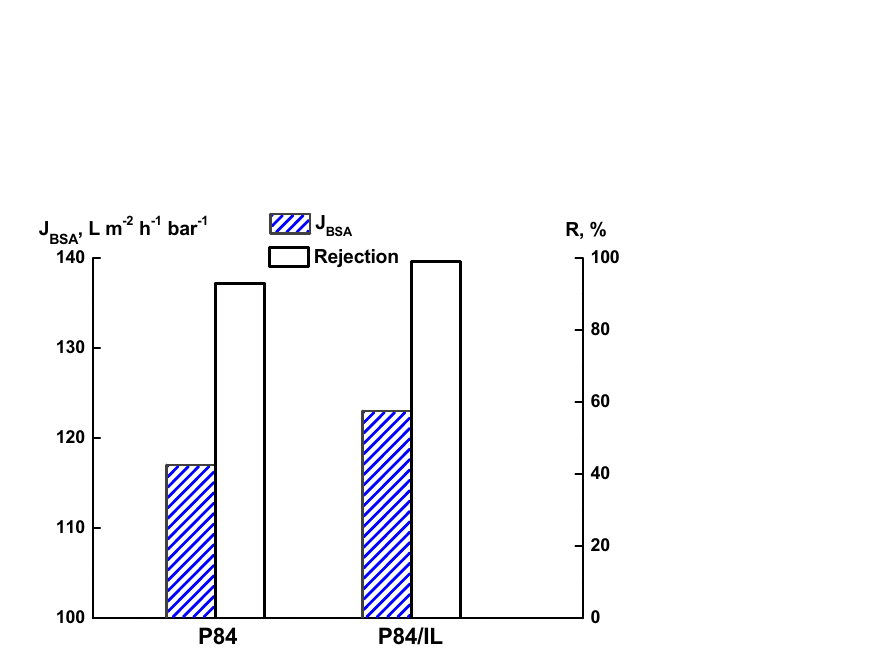
Figure 7. SEM micrographs of the membrane cross-section and top surface for ( a , b ) the P84 and ( c , d ) P84/IL membranes.